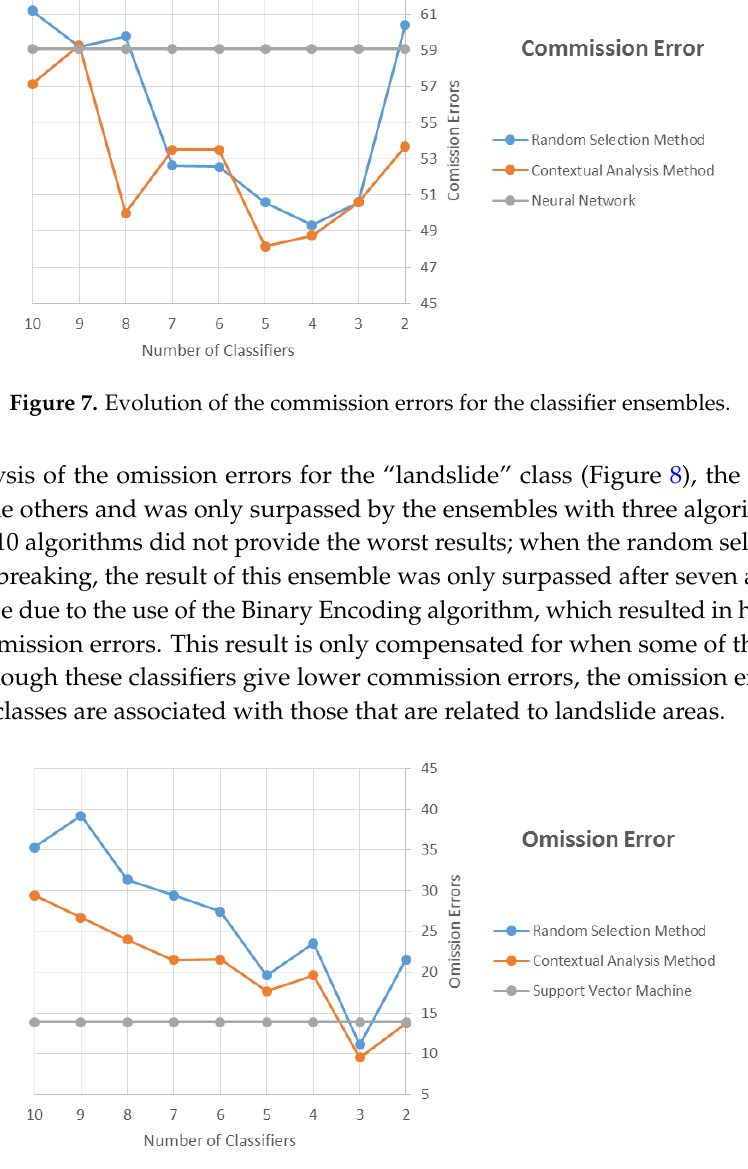
Figure 8. Evolution of the omission errors for the classifier ensembles.